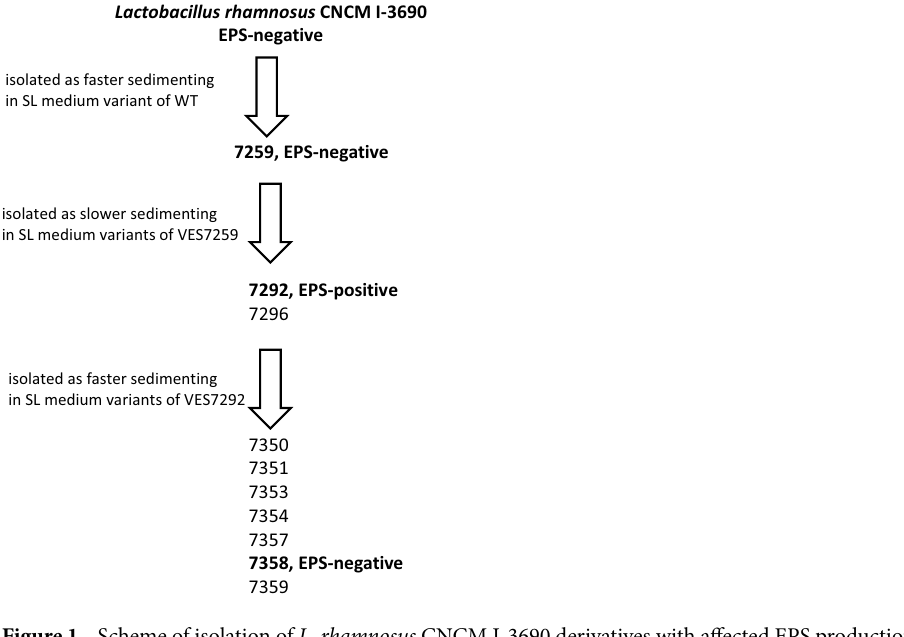
Figure 1. Scheme of isolation of L. rhamnosus CNCM I-3690 derivatives with affected EPS